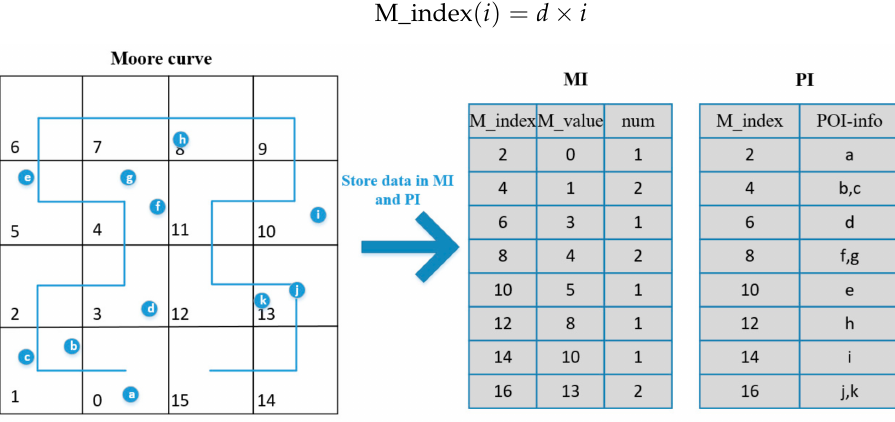
Figure 3. MI and PI list.